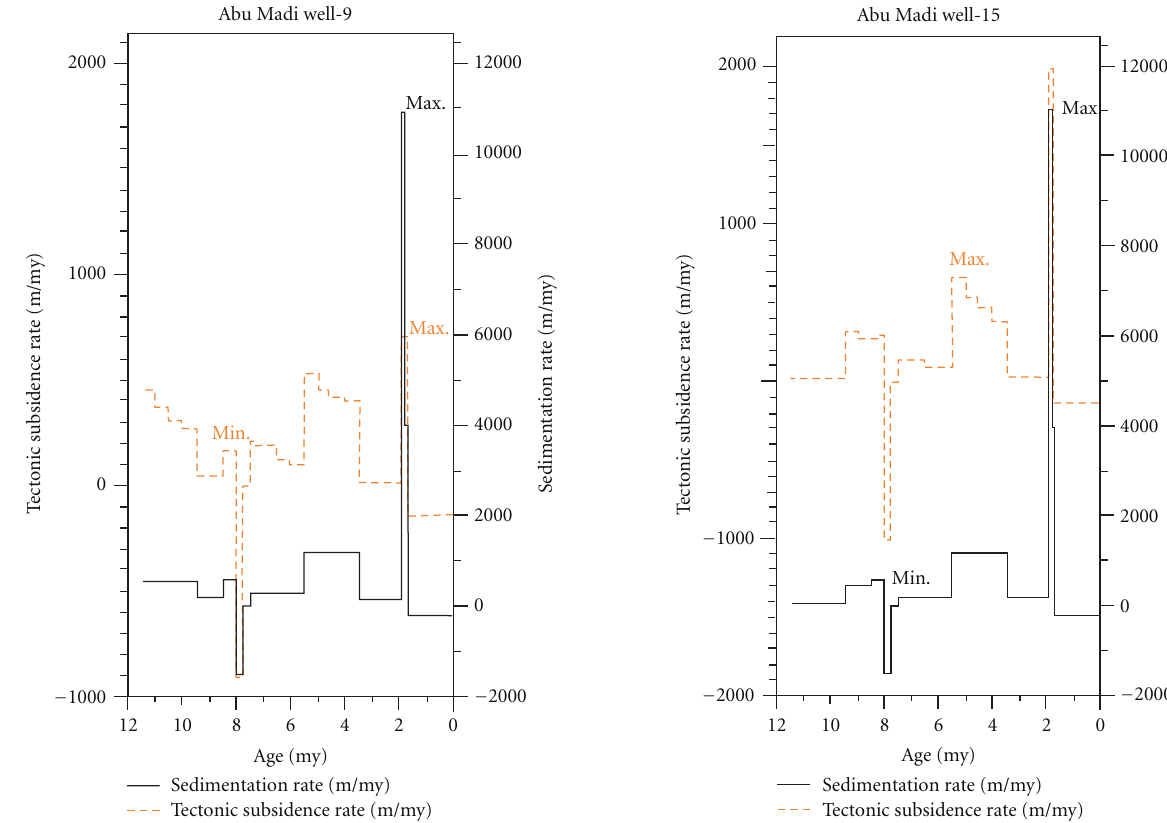
Figure 9: Tectonic subsidence rate for Abu Madi-9 well, showing period of nondeposition and period of increasing rate of subsi- dence/sedimentation.